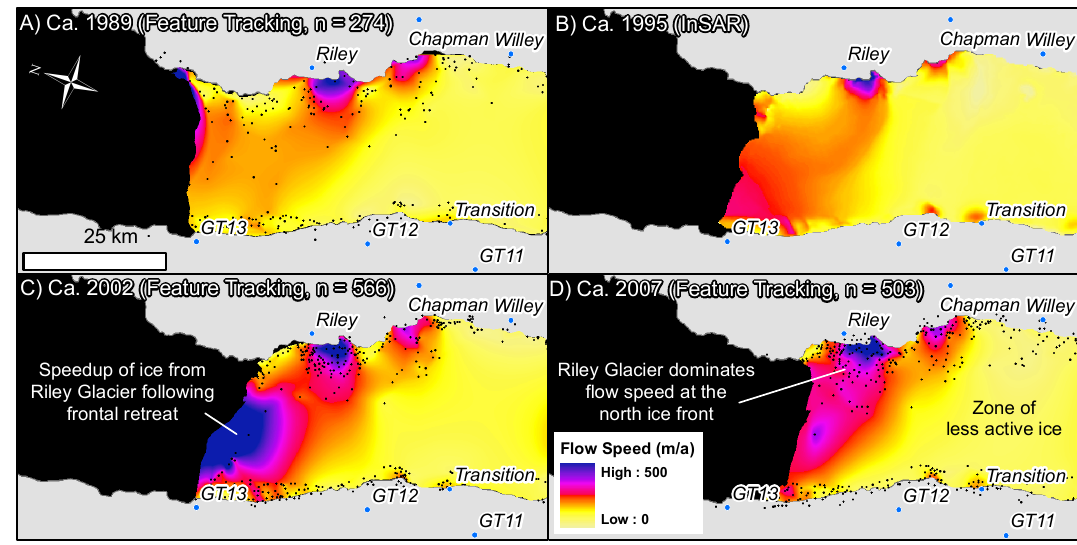
Fig. 6. Surface-speed calculations at the north ice front for ca. 1989 (A) , ca. 1995 (B) , ca. 2002 (C) and ca. 2007 (D) illustrating an increase in flow speed of glacier ice flowing from Riley Glacier as the ice front retreated upstream. Less active ice is apparent in each observation period that is inferred to be buttressed by the dominant flow from Riley Glacier at the ice front. Black dots represent the centre point of tracked features that were used to interpolate surface speeds. Uncertainties: (A) ±30ma − 1 , (B) ±25ma − 1 , (C) 15 ±ma − 1 , (D) ±15ma − 1 .